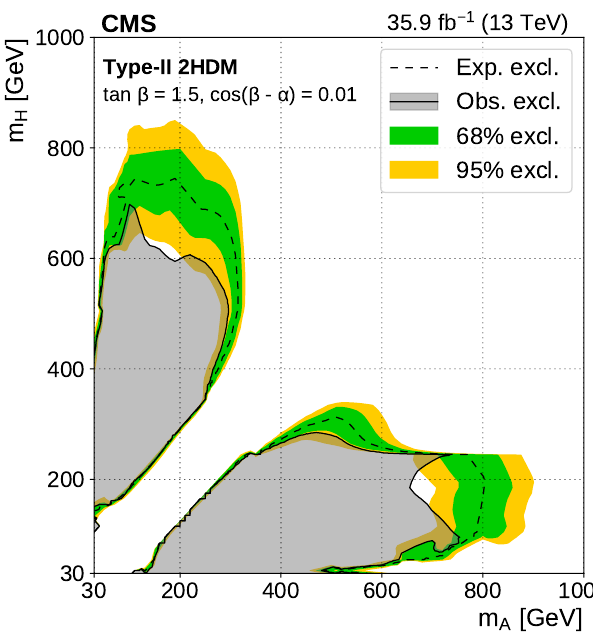
Figure 8 . Expected and observed 95% CL exclusion contours for the Type-II 2HDM benchmark tan (cid:12) = 1 : 5 and cos( (cid:12) (cid:0) (cid:11) ) = 0 : 01 as a function of m and m . The inner (green) band and the A H outer (yellow) band indicate the regions containing 68 and 95%, respectively, of the distribution of the exclusion contours expected under the background-only hypothesis. The limits are computed using the asymptotic CL method, combining the ee and (cid:22)(cid:22) s